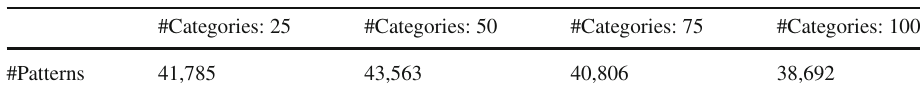
Table 5 #Patterns of different #categories of patterns for music